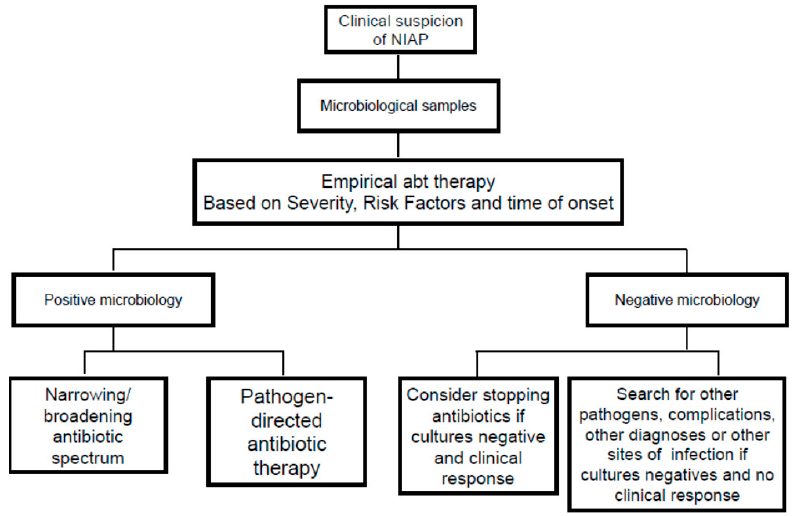
Figure 5. Management strategies for a patient with suspected non ICU acquired pneumonia (NIAP).